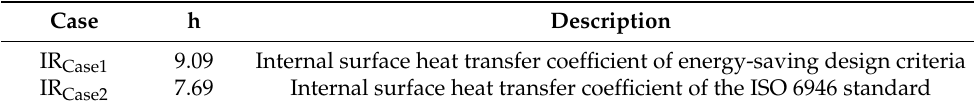
Table 4. Measurement cases using the IR method.